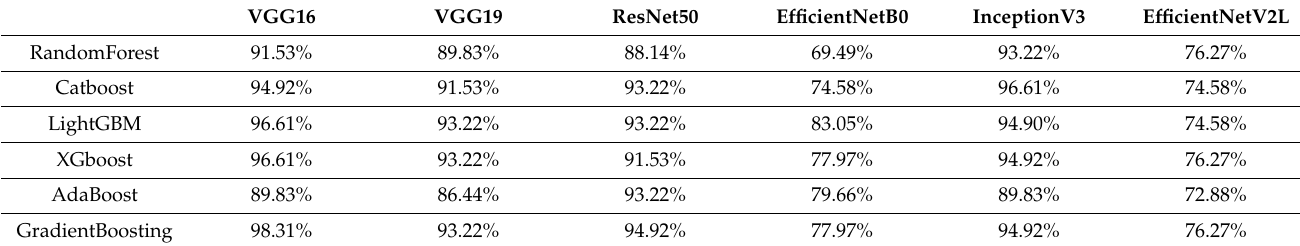
Table A16. Accuracy of each model combination for blue circles.